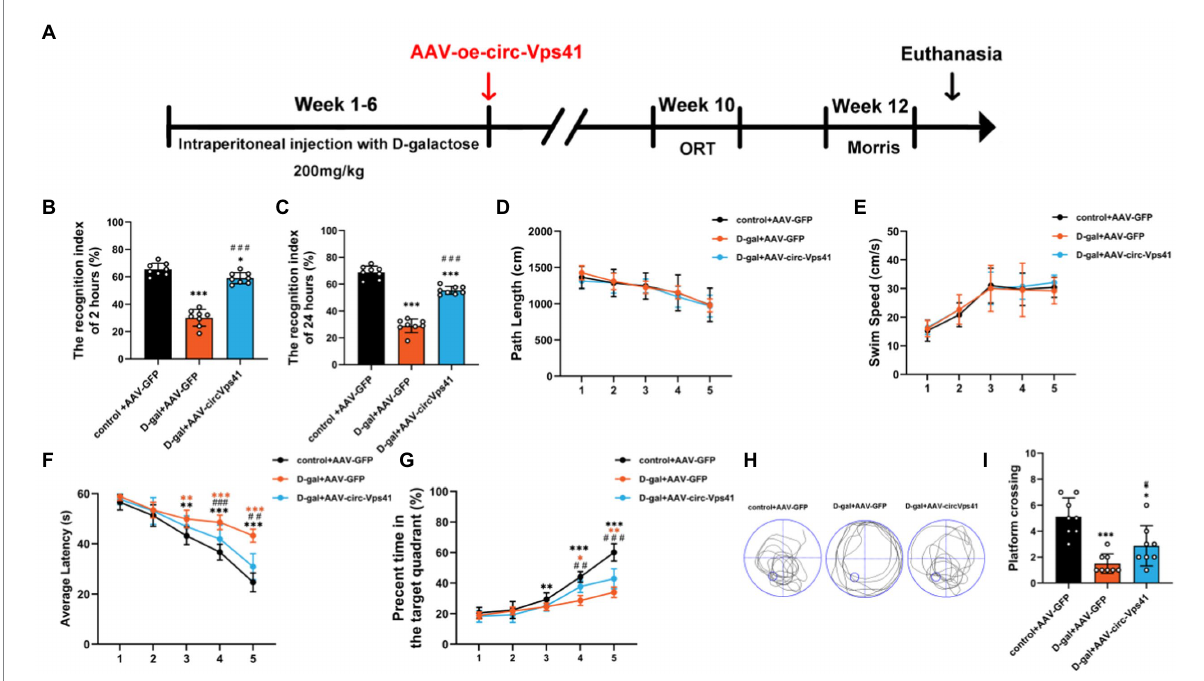
FIGURE 6 Overexpression of circ-Vps41 reversed D-galactose-induced learning and memory impairment in mice (A) Experimental schematic diagram. After 6 weeks of continuous intraperitoneal injection with D-galactose, the adeno-associated virus vector with fluorescence-specific overexpression of circ-Vps41 (AAV-circ-Vps41) and the control GFP were injected by brain stereotactic technology into the hippocampal CA1 area of D-galactose- treated mice. (B,C) ORT test of mice at 2 h and 24 h. (D,E) Total path length and average swim speed by mice to reach the platform during the training trials. (F,G) Time taken by mice to reach the platform and percentage of time in the target quadrants during the training trials. (H,I) Representative swimming paths of mice and numbers of platform crossings on Day 7 of the MWM ( n = 8 for the control+AAV-GFP group, n = 8 for the D-gal+AAV-GFP group, n = 8 for the D-gal+AAV-circ-Vps41 group). * p < 0.05, ** p < 0.01, *** p < 0.001 vs. control+AAV-circRNA NC group; # p < 0.05, ## p < 0.01, ### p < 0.001 vs. D-gal+AAV-GFP group; Data are shown as the mean ± SEM. p values, two-tailed t -test, one-way ANOVA, repeated measures and multivariate analysis of